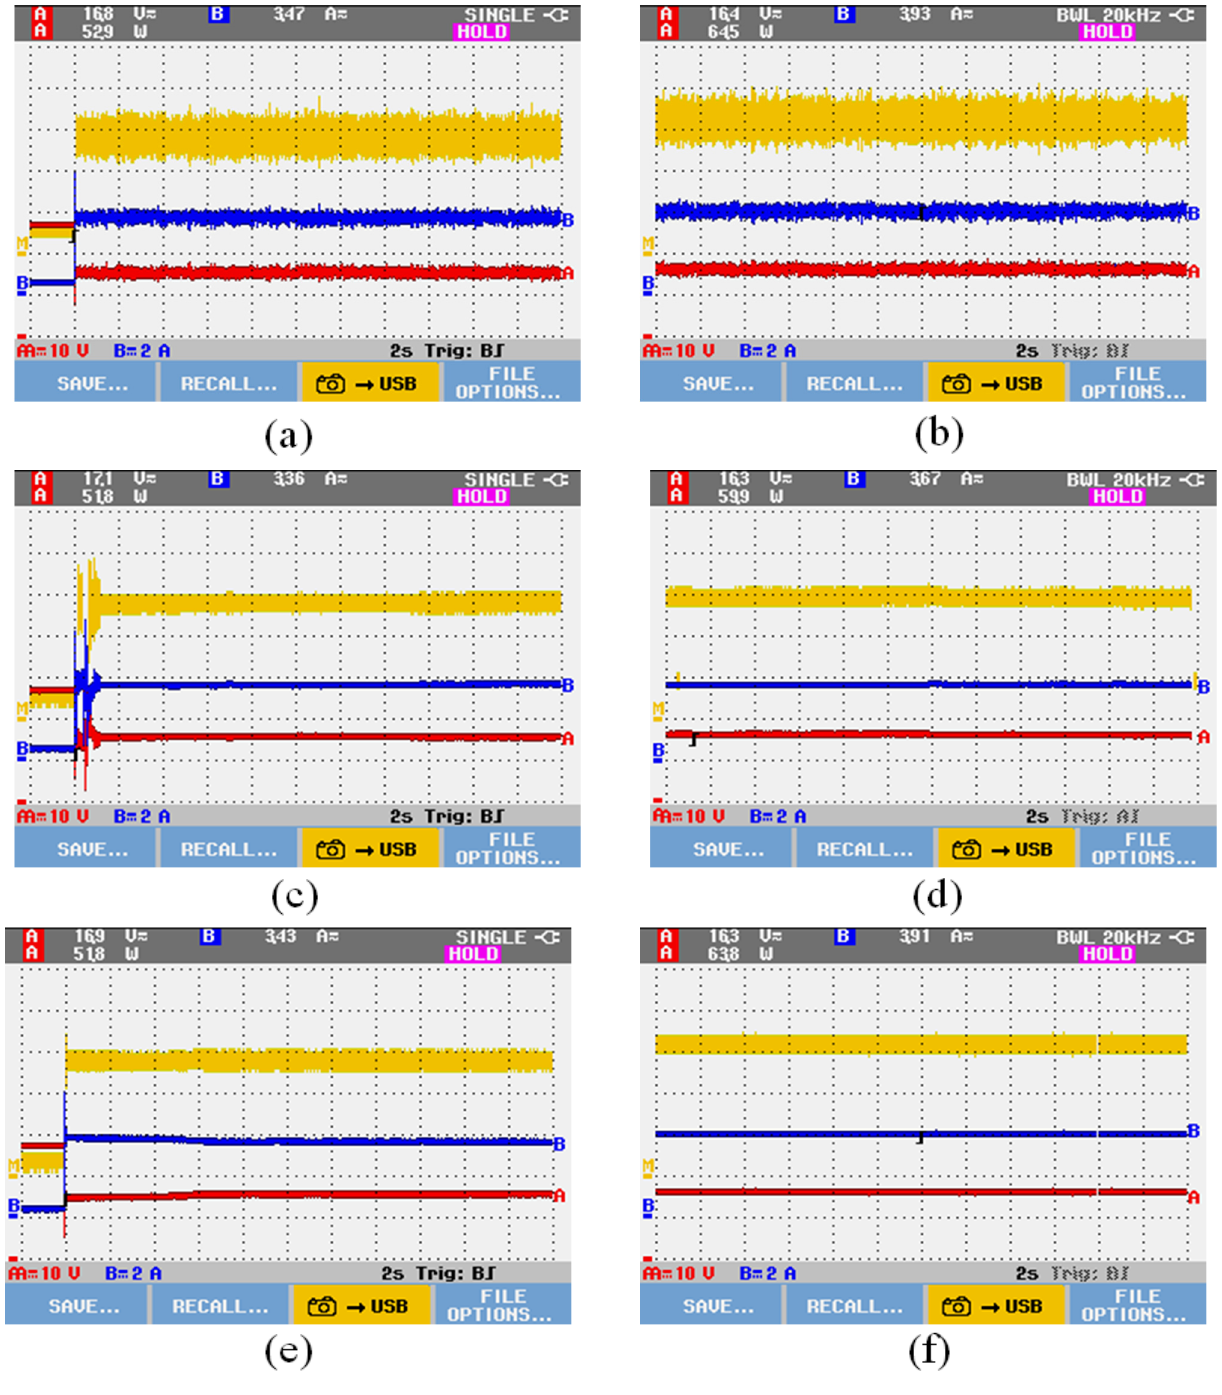
Figure 13. The convergence waveform in the practical experiment under (UI): ( a ) the transient waveform of the P&O method, ( b ) the steady-state waveform of the P&O method, ( c ) the transient waveform of the CSA method, ( d ) the steady-state waveform of the CSA method, ( e ) the transient waveform of the ICSA method, and ( f ) the steady-state waveform of the ICSA method. From this test, the results indicate that the proposed ICSA has a shorter time to track the GMPP with higher stability than the other two methods.